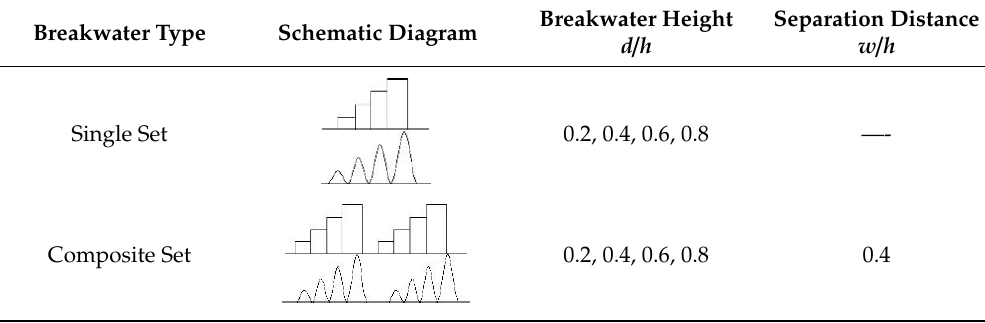
Figure 3. Single ( a ) rectangular and ( b ) undulating breakwater set.